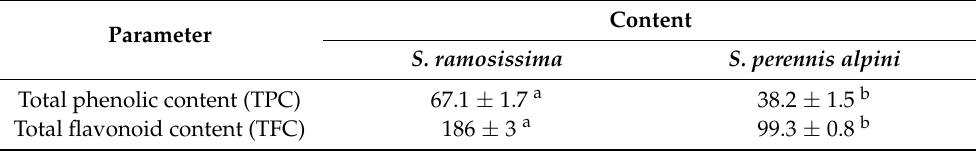
Table 3. Total phenolic content (TPC) and total flavonoid content (TFC) of Salicornia ramosissima and Sarcocornia perennis alpini expressed in mg of gallic acid equivalents per g of extract dry weight (mg GAE/g extract dw) and mg of epicatechin equivalents per g of extract dry weight (mg ECE/g extract dw), respectively (mean ± SD; n =